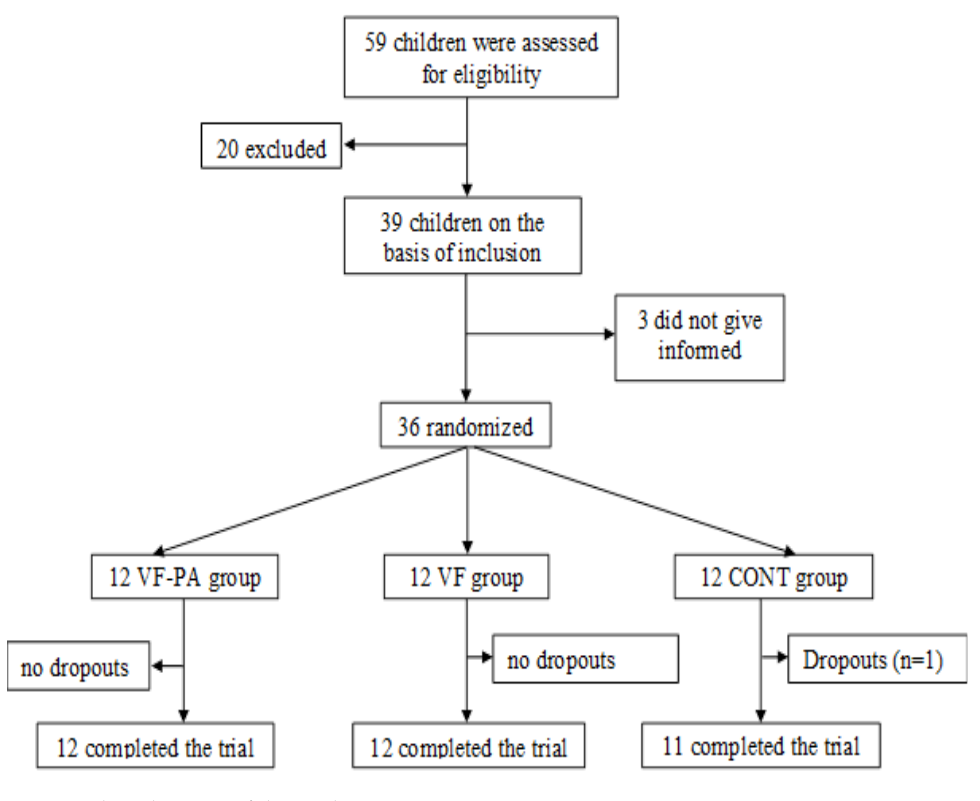
Figure 3. Flow diagram of the study.